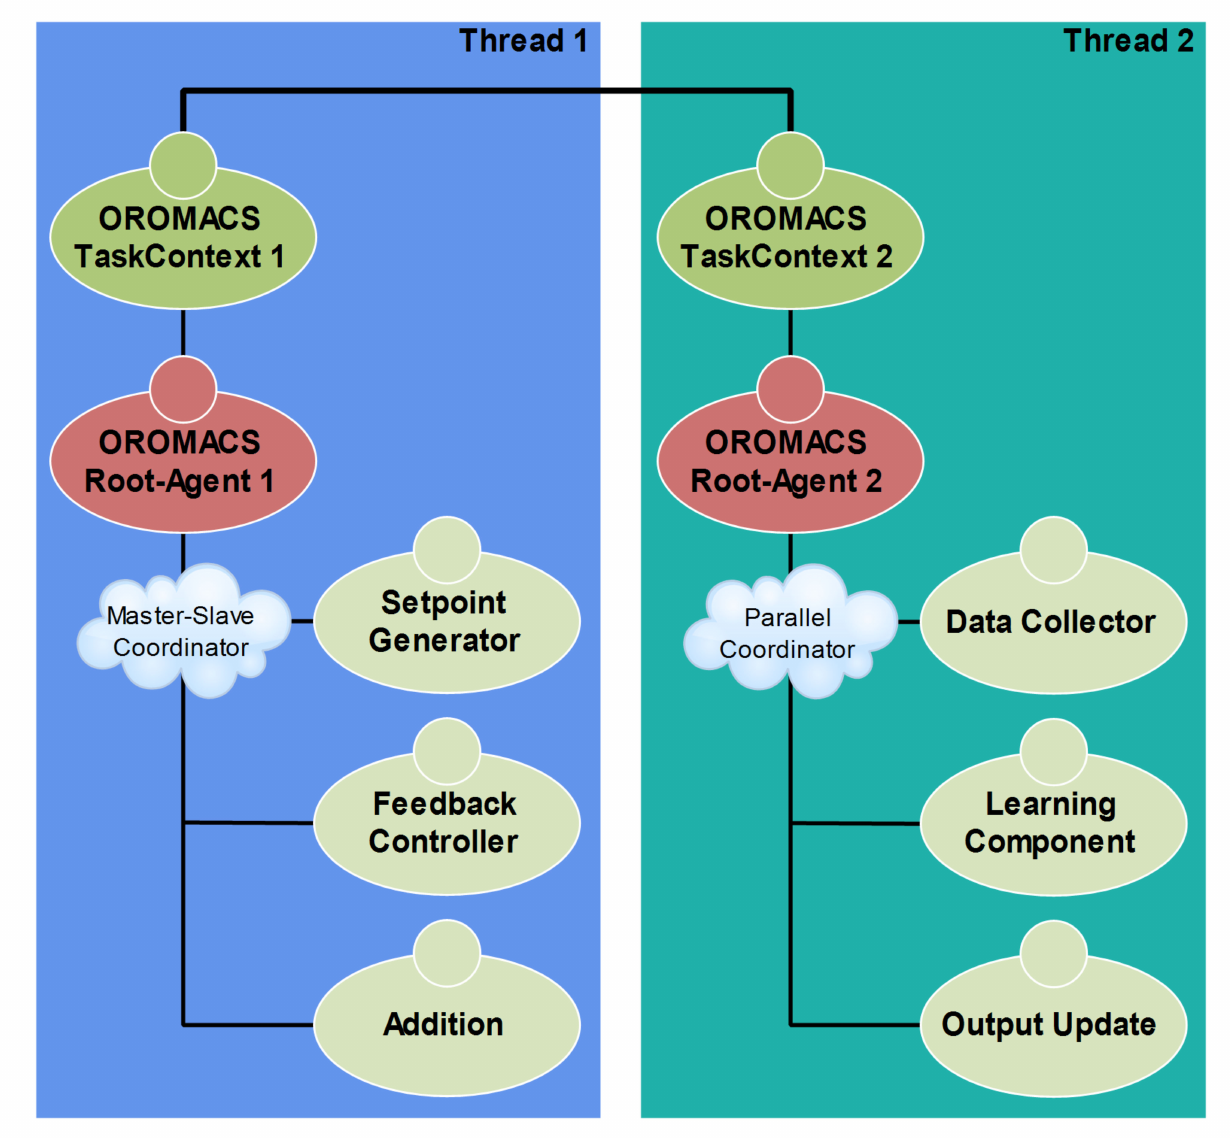
Figure 6. Hierarchical organization of the MACS-based time-index LFFC